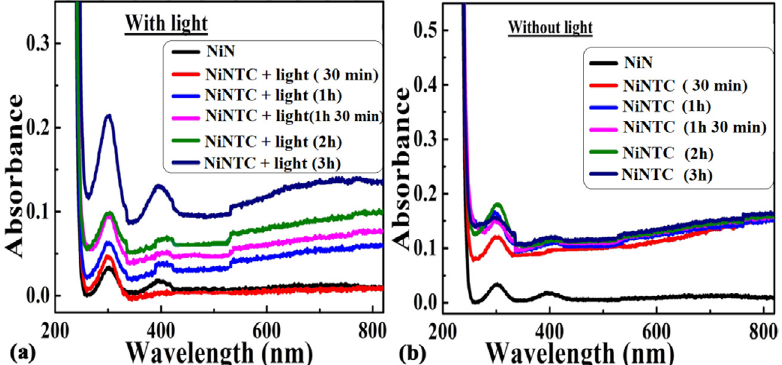
Fig. 2. Absorbance spectra of nickel nitrate treated with nanocomposite (a) under light irradiation; (b) without light